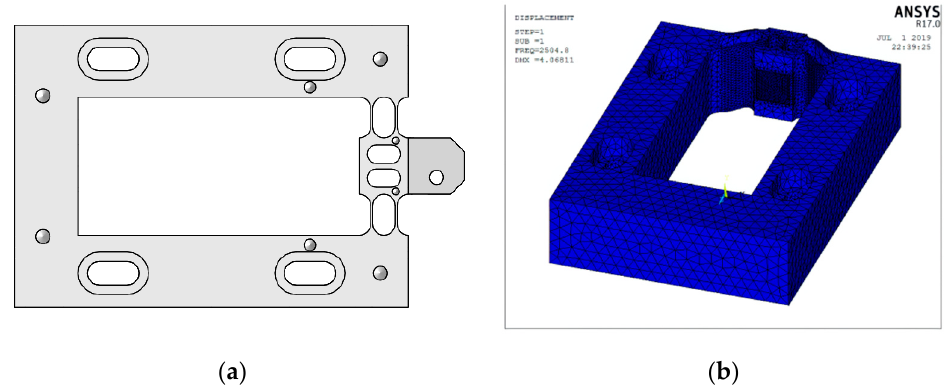
Figure 3. ( a ) Straight beam length; ( b ) minimum thickness.